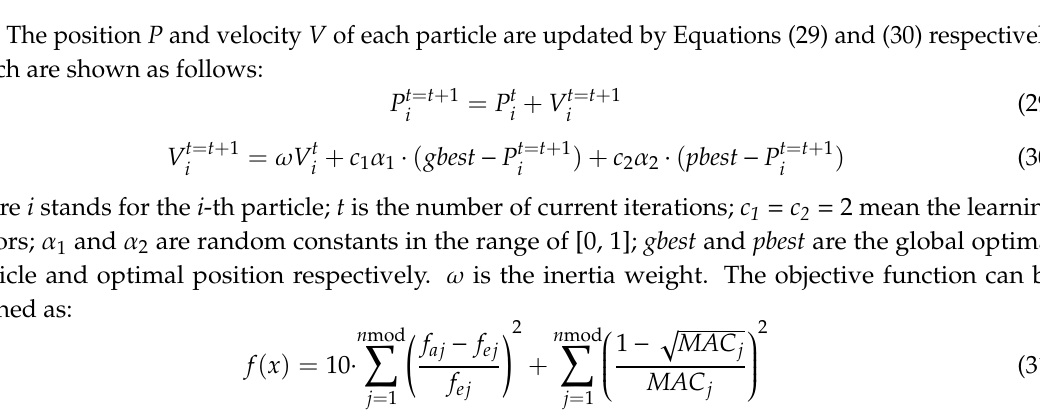
Figure 15. Linear relationship between elastic modulus and temperature.